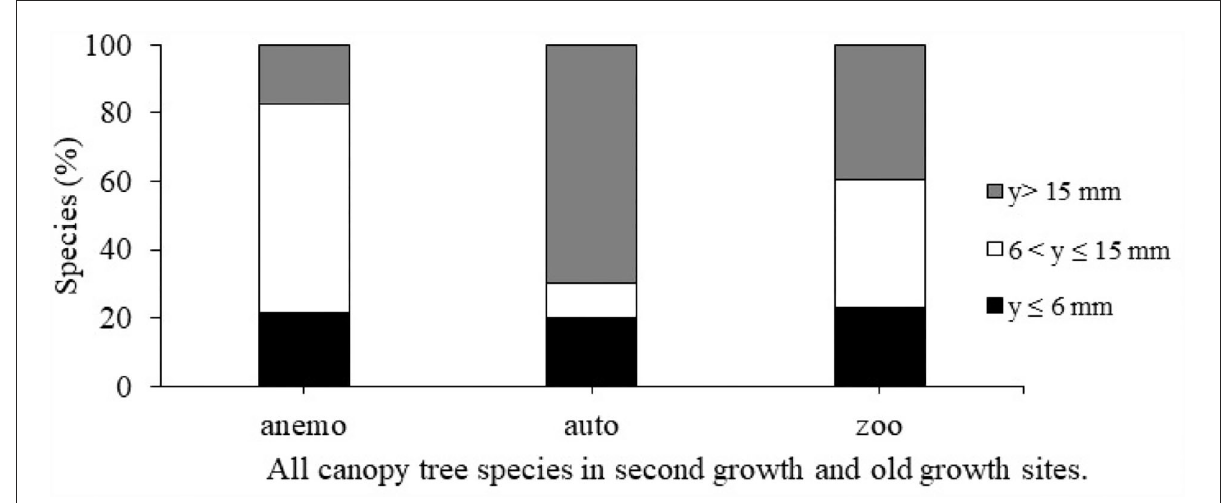
FIGURE1 The percent of species in each dispersal mode in three size categories: y ≤ 6mm; 6 < y ≤ 15mm; y > 15mm. Each bar represents 100% of species in that category.